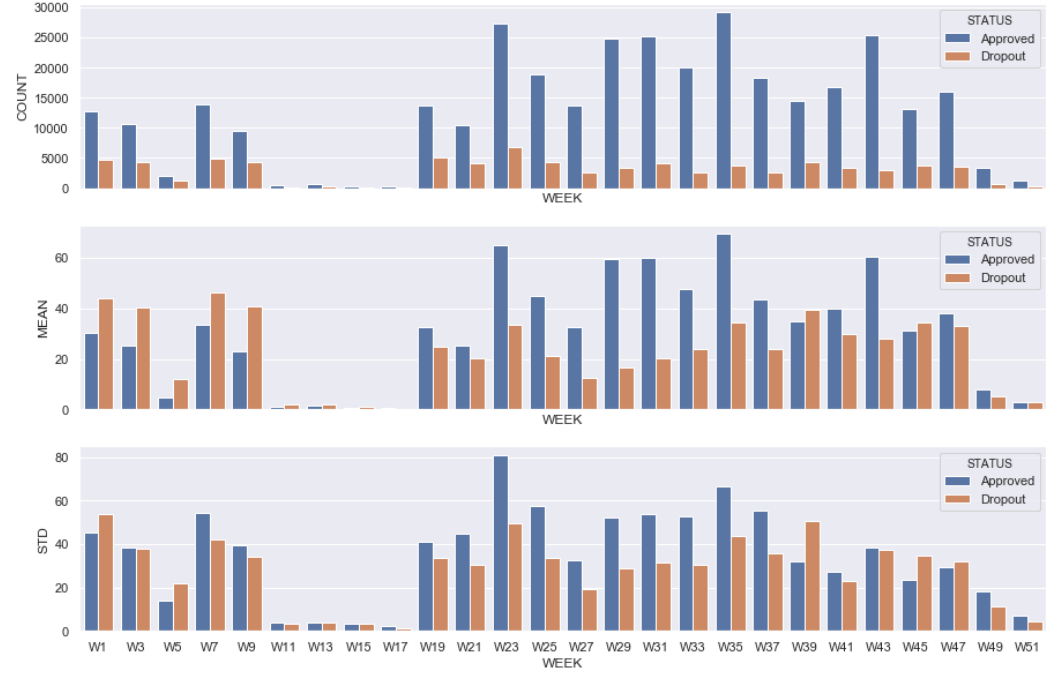
Figure 2. Interactions every two